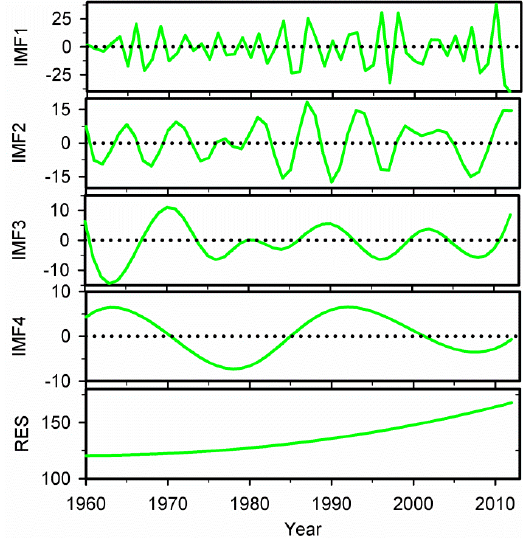
Figure 4. The IMFs and trend component of average annual precipitation time series in Xinjiang during 1960–2012 by EEMD.